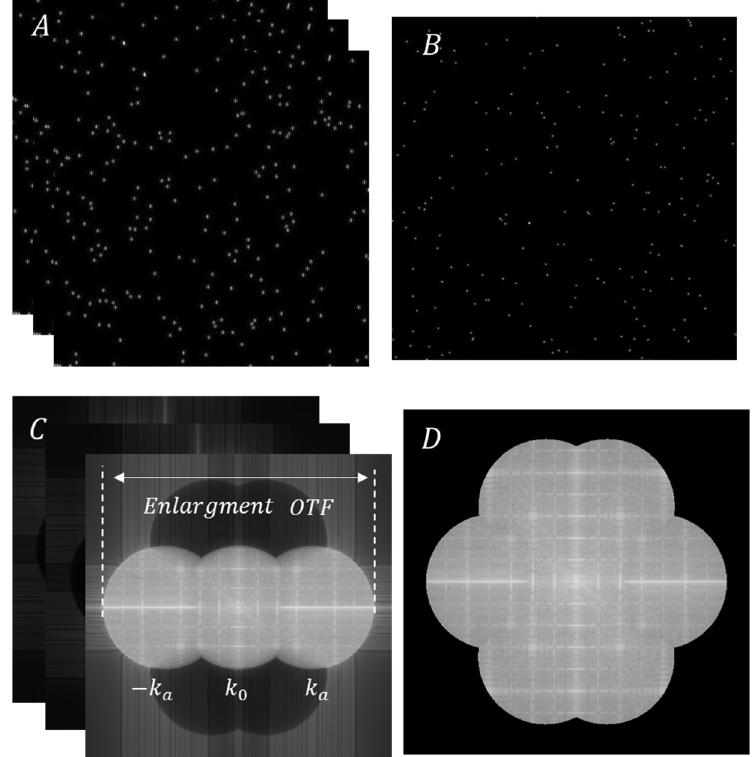
Figure 3. Multidimensional spatial frequency expansion. ( A ) Series of images at different sinusoidal fringe pattern illumination phases. ( B ) Final reconstructed super-resolution image. ( C ) Recombina- tion of all components by separating the individual parts, shifting the frequency information by a distance of ± k a to the original location. The three segment spectra are superimposed to generate an extended OTF passband. ( D ) Expansion spectrum of multi-directional frequency.